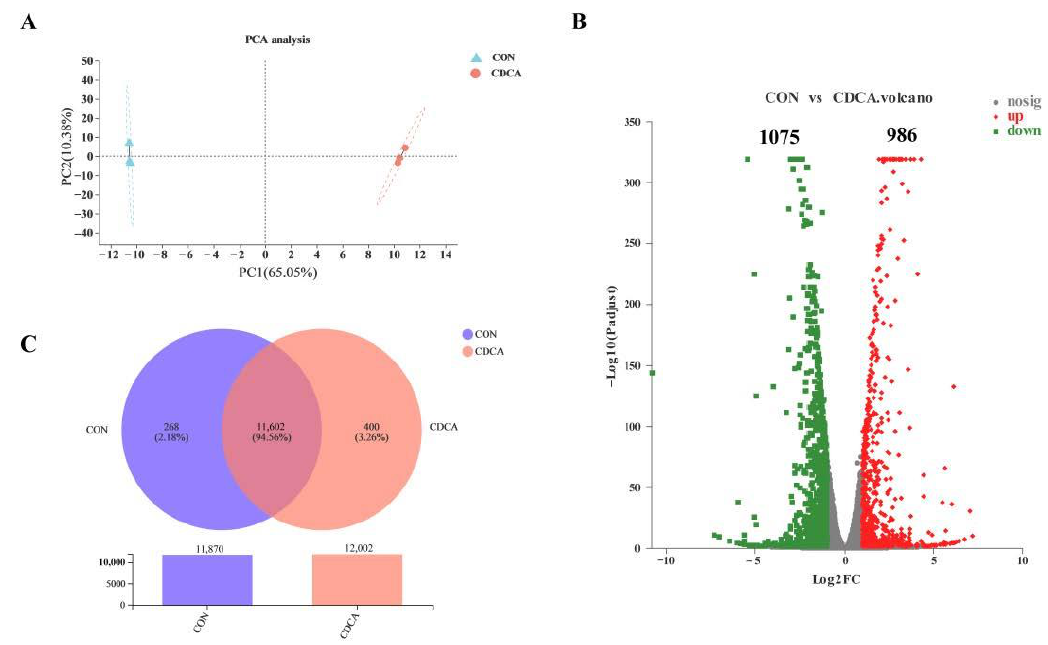
Figure 5. Effects of CDCA on the DEGs of IPEC-J2 cells ( n = 3). PCA plot of the transcriptional profiles between the two groups ( A ). Volcano plot of DEGs between CON and CDCA groups ( B ). The red, green, and gray dots indicate the significantly upregulated, significantly downregulated, and unchanged genes, respectively. The Venn diagram showed the number of specifically expressed genes in each group, as well as the overlapping co-expressed genes between CON and CDCA groups ( C ). DEGs, differentially expressed genes.